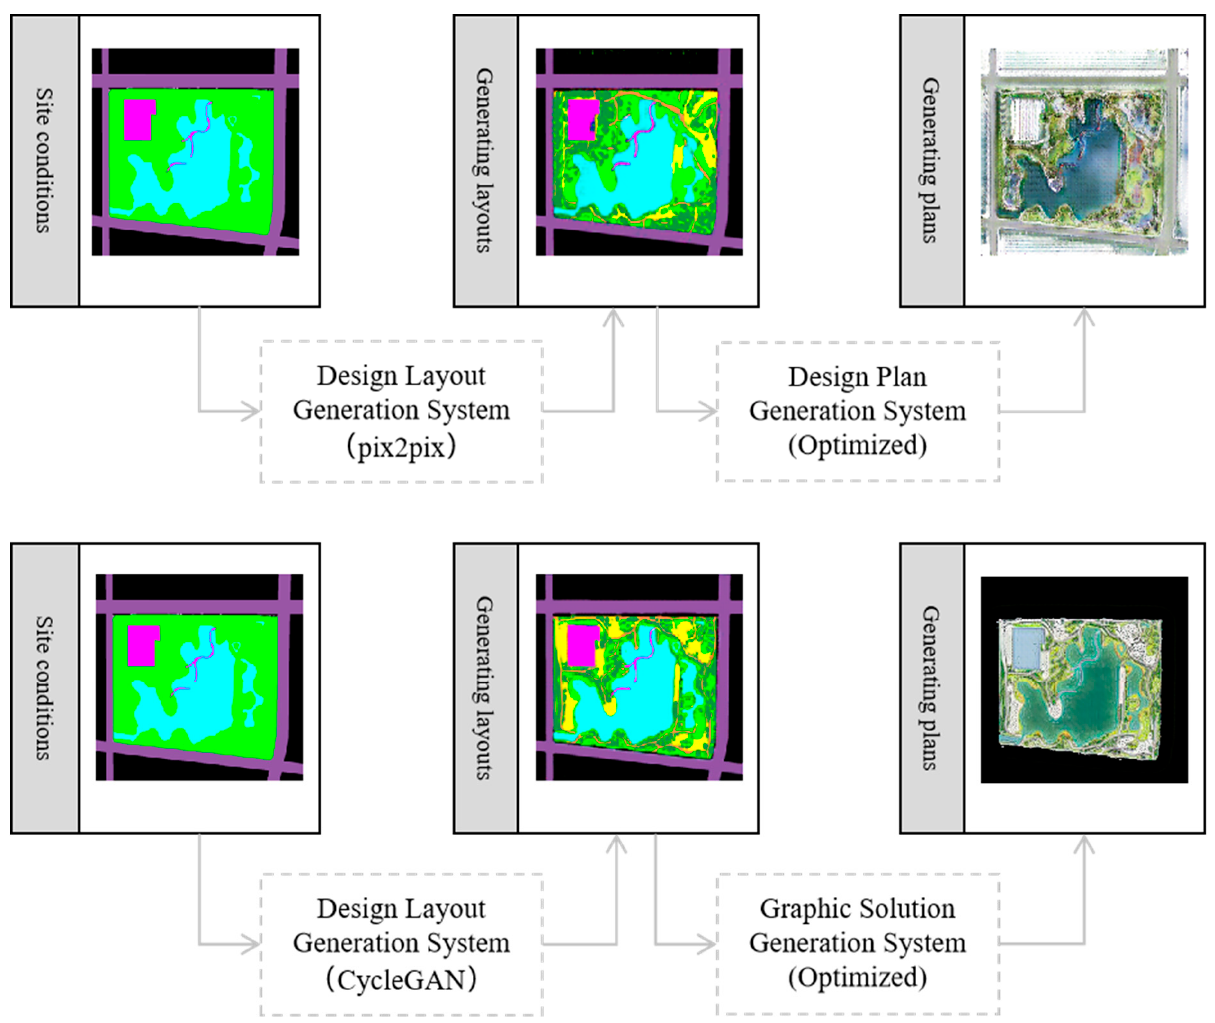
Figure 9. The work fl ow of algorithm evaluation. Figure 9. The workflow of algorithm